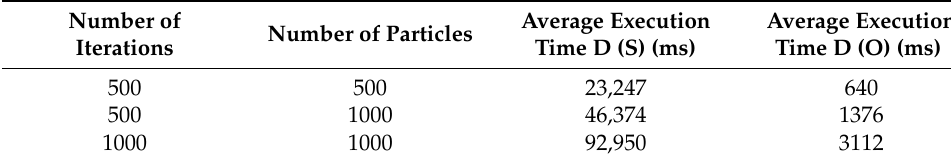
Table 2. Performance comparison between platform D (O) and D